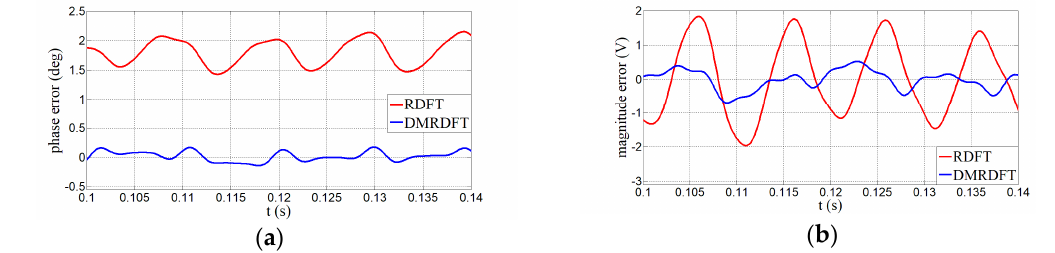
Figure 16. The contrast of the RDFT and DMRDFT performance with the interharmonics: ( a ) phase error, and ( b ) magnitude error.